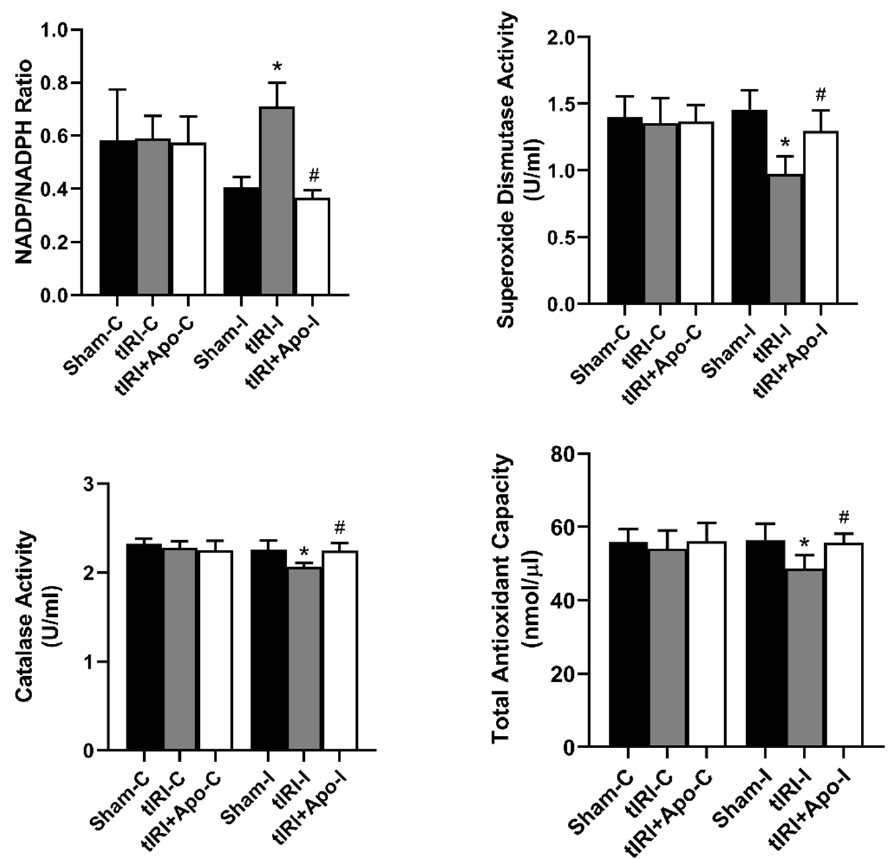
Figure 1. Testicular tissue levels of oxidants and antioxidants. The tissue levels of NADP/NADPH ratio and total antioxidant capacity were measured using colorimetric assays. In addition, the enzyme activities of superoxide dismutase and catalase were determined using their respective colorimetric assay kits. Data are presented as mean ± SD ( n = 6/group), p -value < 0.05. * tIRI compared to sham and # apocynin-treated compared to tIRI.